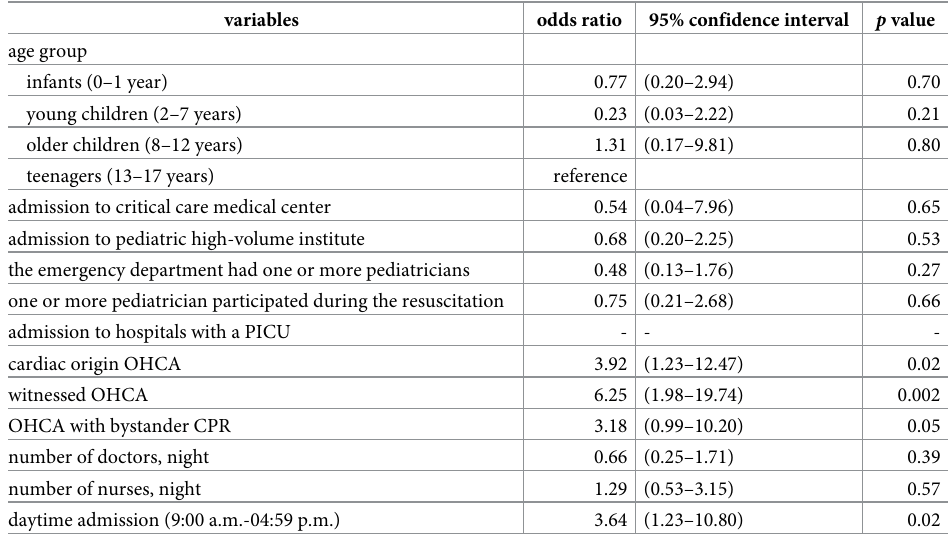
Table 2. Factors associated with 1-month